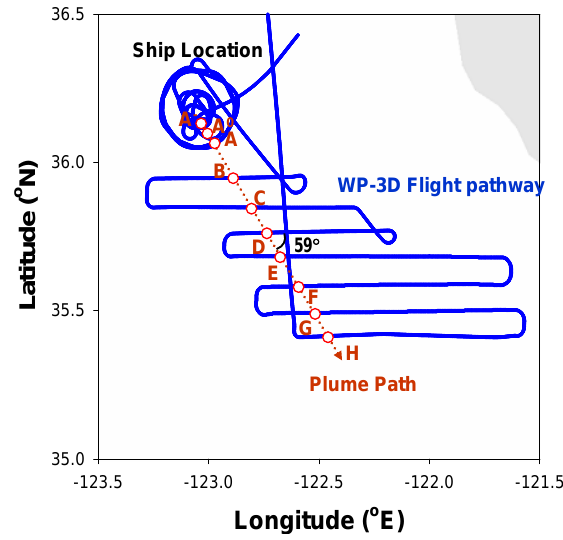
Fig. 1. Two imaginary ship-plume transects (A − and A ◦ ) and eight actual ship-plume transects (A–H) made by a NOAA WP-3D flight during the ITCT 2K2 campaign conducted 100km off the California coast (Chen et al., 2005; Kim et al., 2009).